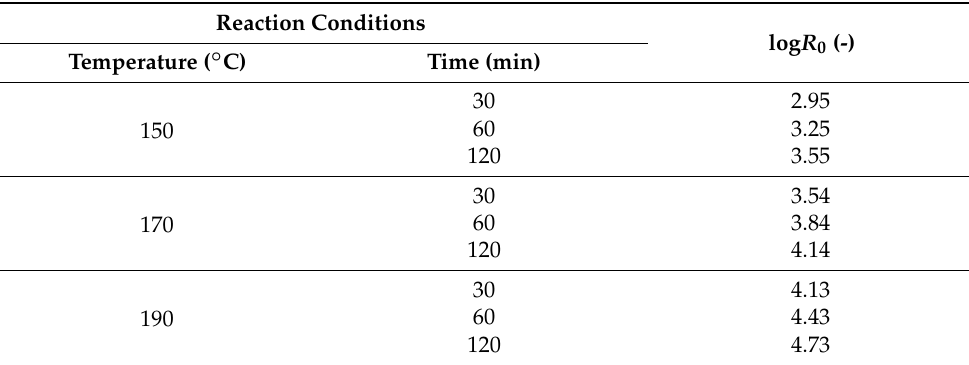
Table 1. Reaction severities vs. reaction temperatures and